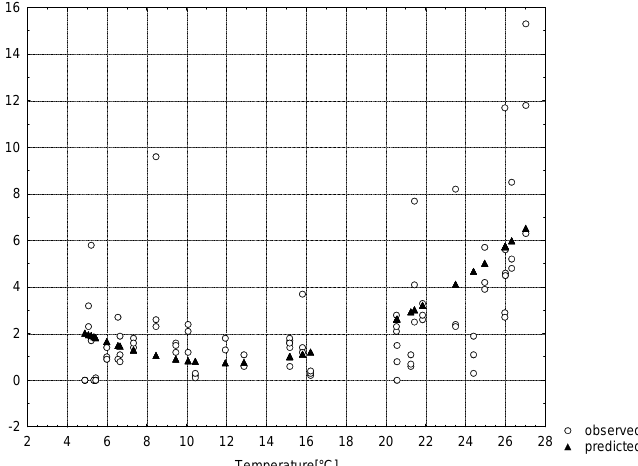
Fig. A.1 Regression results, (left) polynomial regression of the data